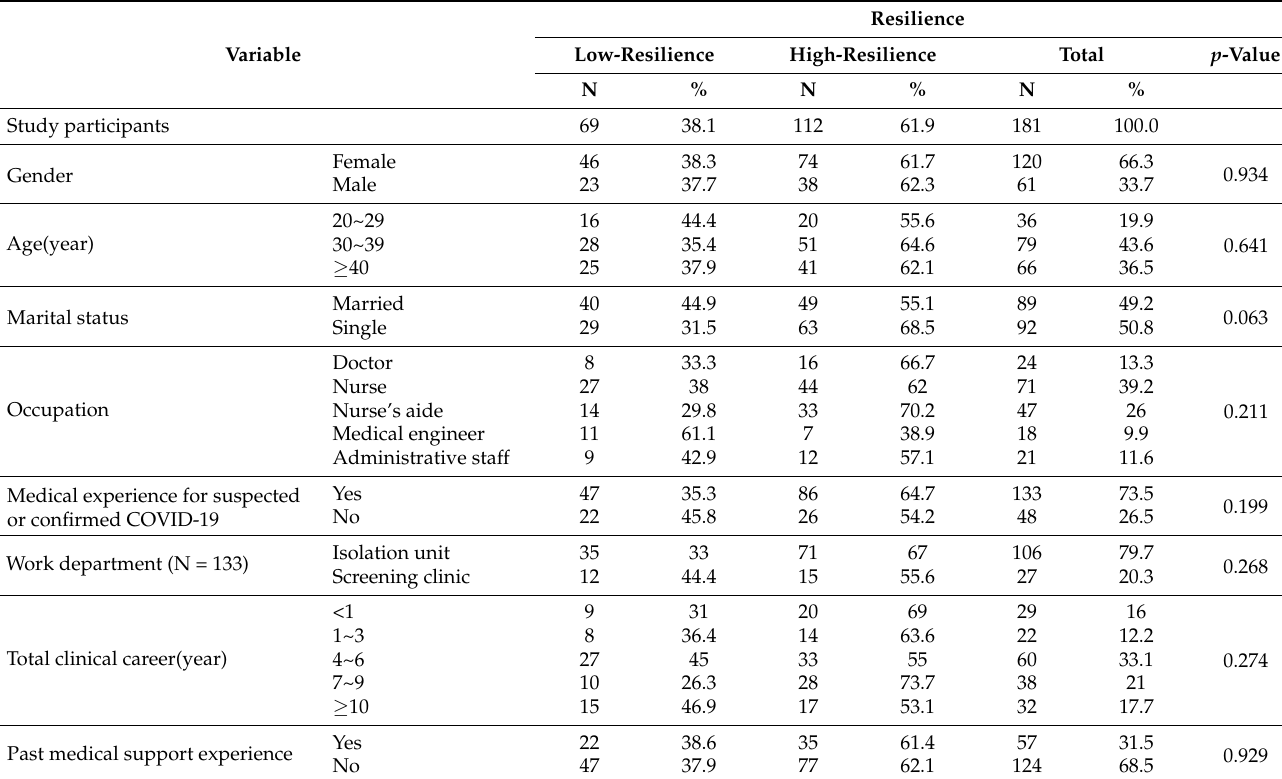
Table 2. Demographic and occupational characteristics according to